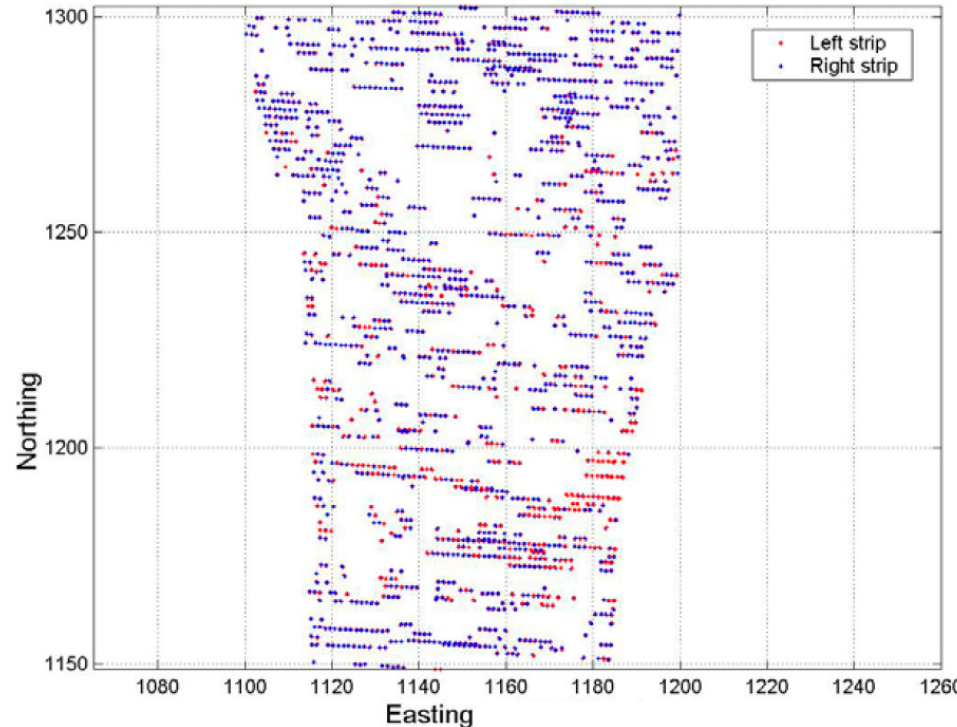
Figure 4. Closer View of the Overlap Region.